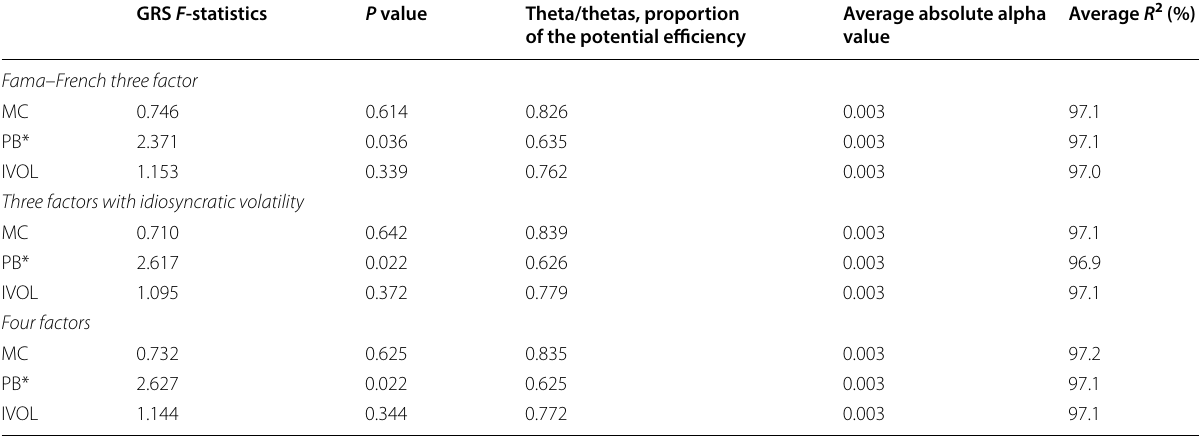
Table 9 Summary of GRS test results for all the factor models